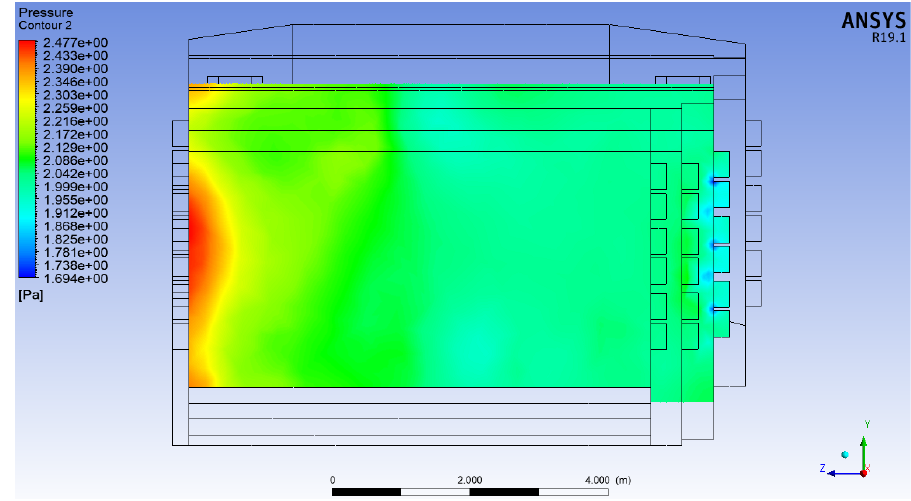
Figure 9. Base Design Pressure